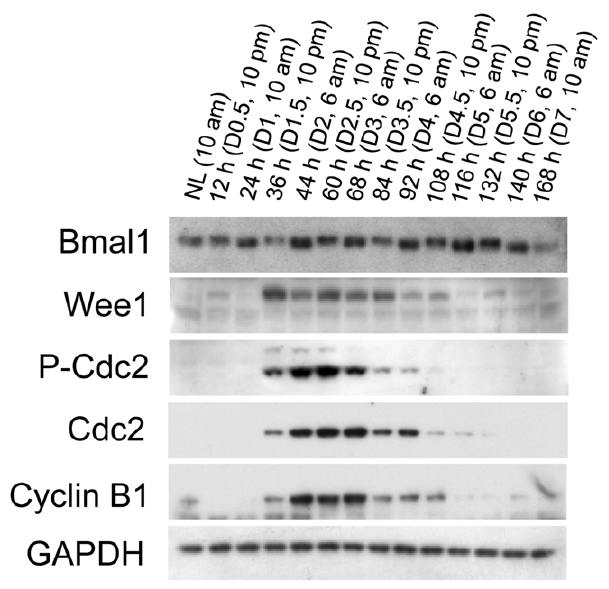
Figure 5. Protein expression of Bmal1, Wee1, Cdc2, and Cdc2 phosphorylated at Tyr 15 (p-Cdc2) in regenerating livers. Livers were collected at the indicated time points from normal mice and the mice subjected to PH. Liver lysates with equal amounts of protein from three mice per time point were pooled. Western blotting was performed with antibodies against the proteins indicated. Glyceralde- hyde 3-phosphate dehydrogenase (GADPH) was used as a loading control. NL, normal liver.